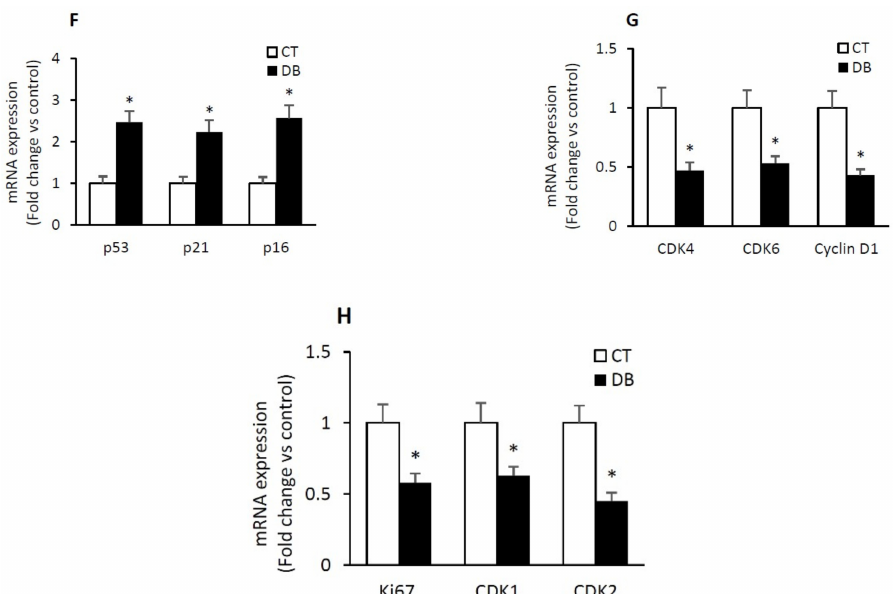
Figure 4. Diabetic W-ECs exhibited a characteristic feature consistent with cellular senescence and cell-cycle arrest. ( A ) Representative images of SA- β -gal staining (left; senescent cells stained with green); accompanied by a barograph figure denoting senescent cells as fold change vs. control. ( B ) mRNA levels of IGFBP5, PAI-1 and TNF- α quantified by qRT-PCR and expressed as a fold change vs. control. ( C ) IL-6 and IL-8 ( D ) in cultured medium of control and diabetic W-ECs quantified by ELISA and expressed as pg/mL. ( E ) Percentage of cells at the S phase measured using flow cytometry and cell cycle PI-based staining. Relative mRNA expression in control and diabetic W-ECs for cell cycle inhibitors (p53, p21, p16, ( F )), cell cycle promoters (CDK4, CDK6, cyclin D1, ( G )) and S-phase gene transcription (Ki67, CDK1, CDk2, ( H )) expressed as a fold change vs. control. Abbreviation: TNF- α , tumor necrosis factor-alpha; IGFBP5, insulin-like growth factor binding protein5; PAI-1, prothrombotic-1; IL-6, interleukin-6; IL-8, interleukin-8, propodium iodide, CDK, cyclin dependent kinase; W-ECs, wound endothelial cells, CT, control; DB, diabetic. Values are means ± SEM ( n = 6) * Significantly different from corresponding control values at p ≤